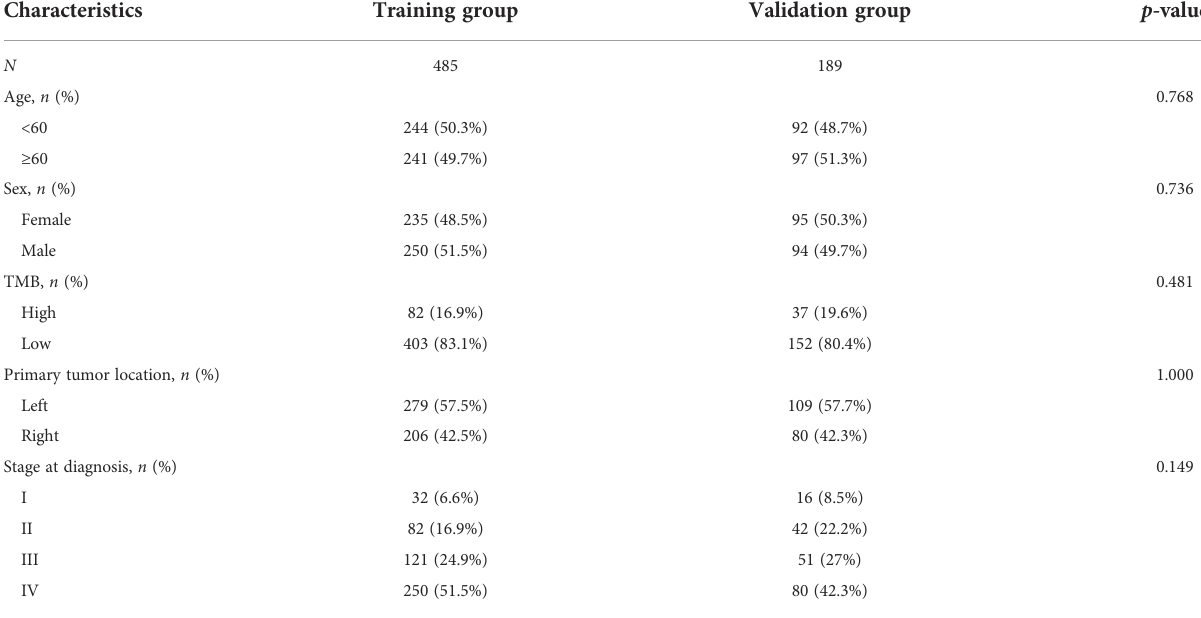
TABLE 5 Comparison of the baseline characteristics between the training and validation groups.